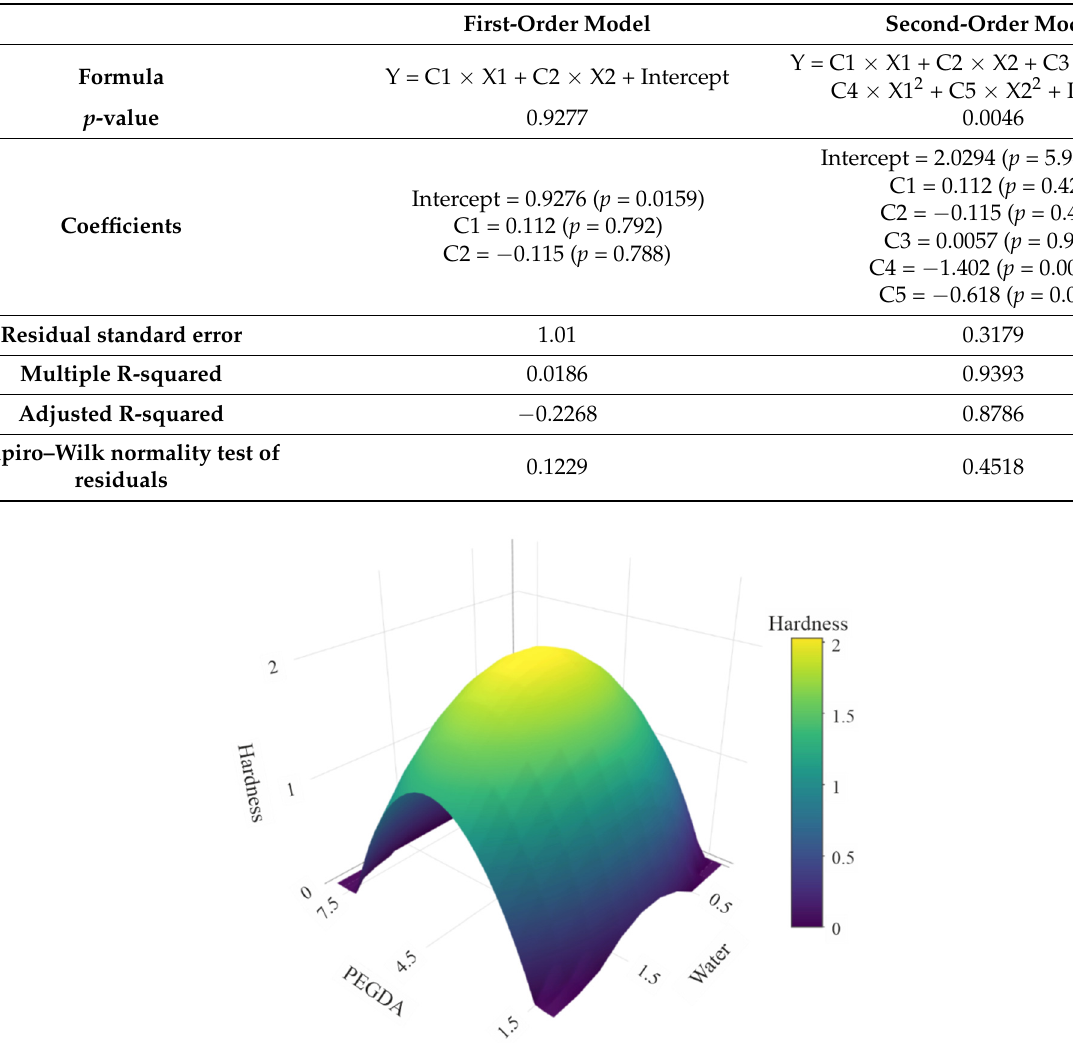
Table 5. Comparison of first-order and second-order models fitted to experimental data. X1—PEGDA; X2—Water, Y—Hardness.